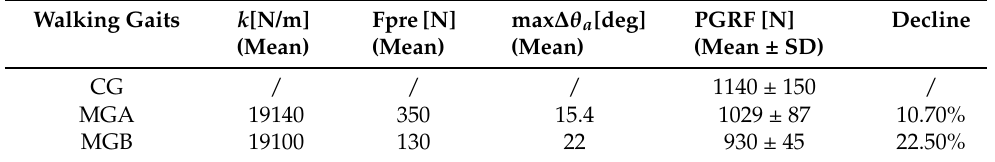
Table 5. Walking PGRF at about 0.5 m/s.